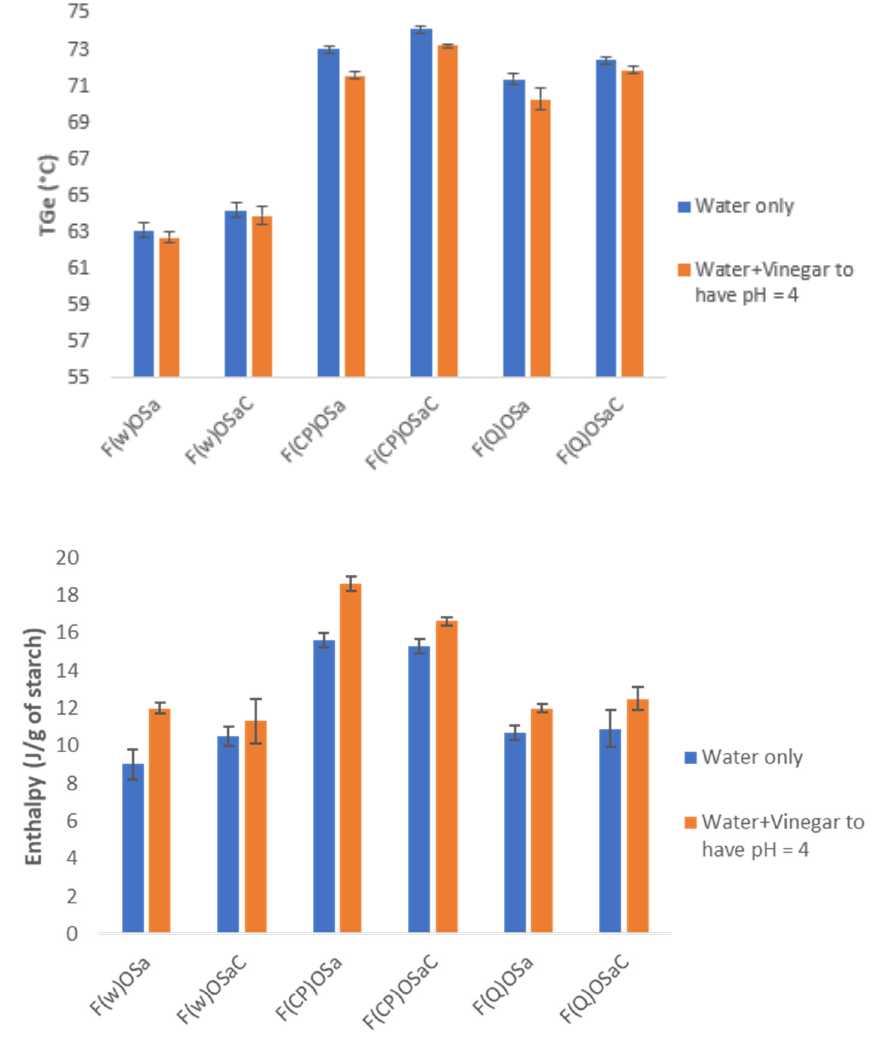
Figure 1. Gelatinization temperatures and enthalpies of different batters (with and without carrot and vinegar) .